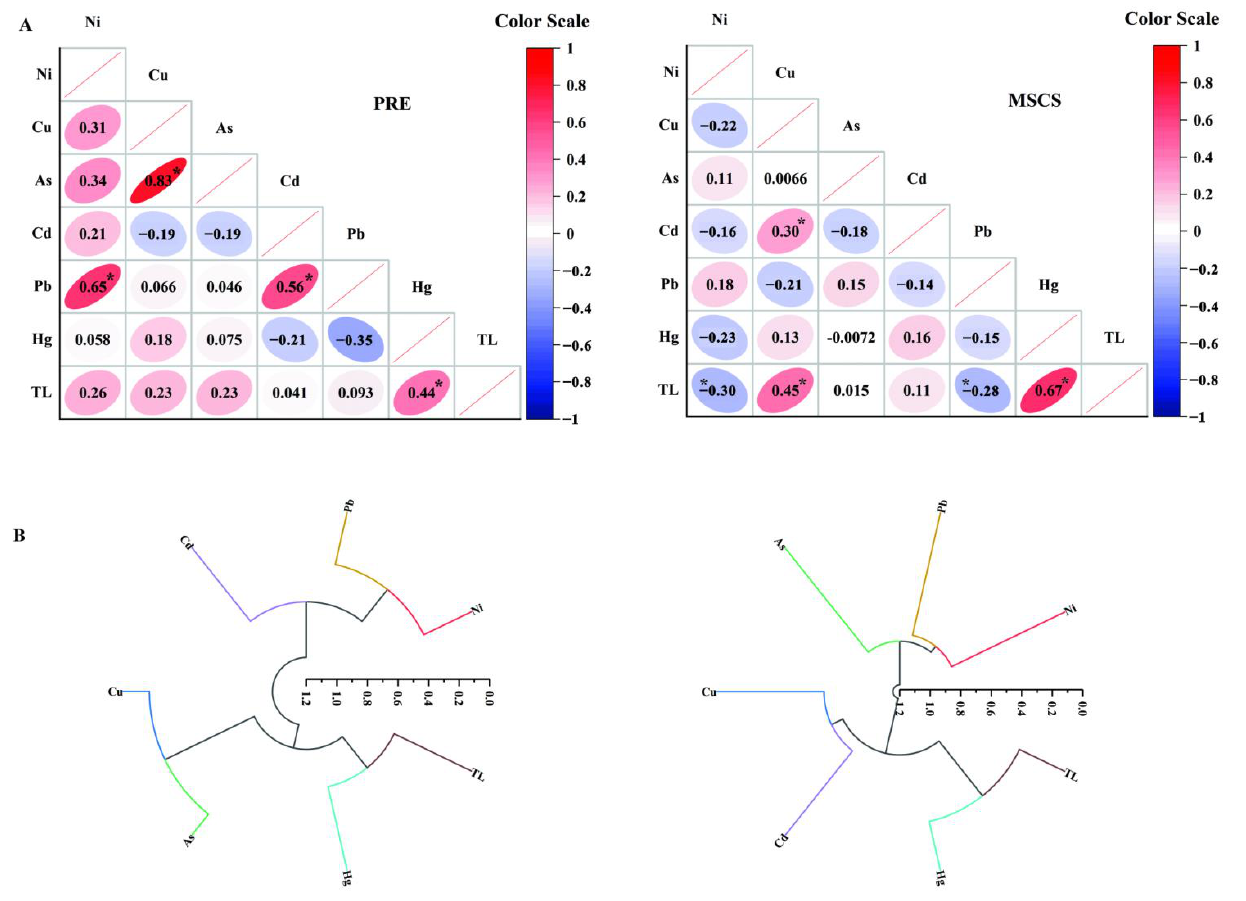
Figure 3. ( A ) Correlation analysis of the heavy metals (HMs) and trophic level (TL) in fish from the Pearl River Estuarine (PRE) and the middle of the South China Sea (MSCS). Data in the ellipses represent the correlation coefficient between the two variables. * Means the significance value p < 0.05. ( B ) Cluster analysis of the HMs and TL in fish from the PRE and the MSCS.